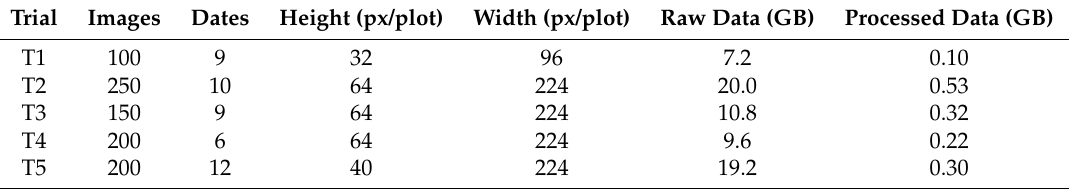
Figure 2. Distribution of ground truth maturity dates and image acquisition dates (blue dots) in each trial. Table 2. Image acquisition details and total storage used for each breeding